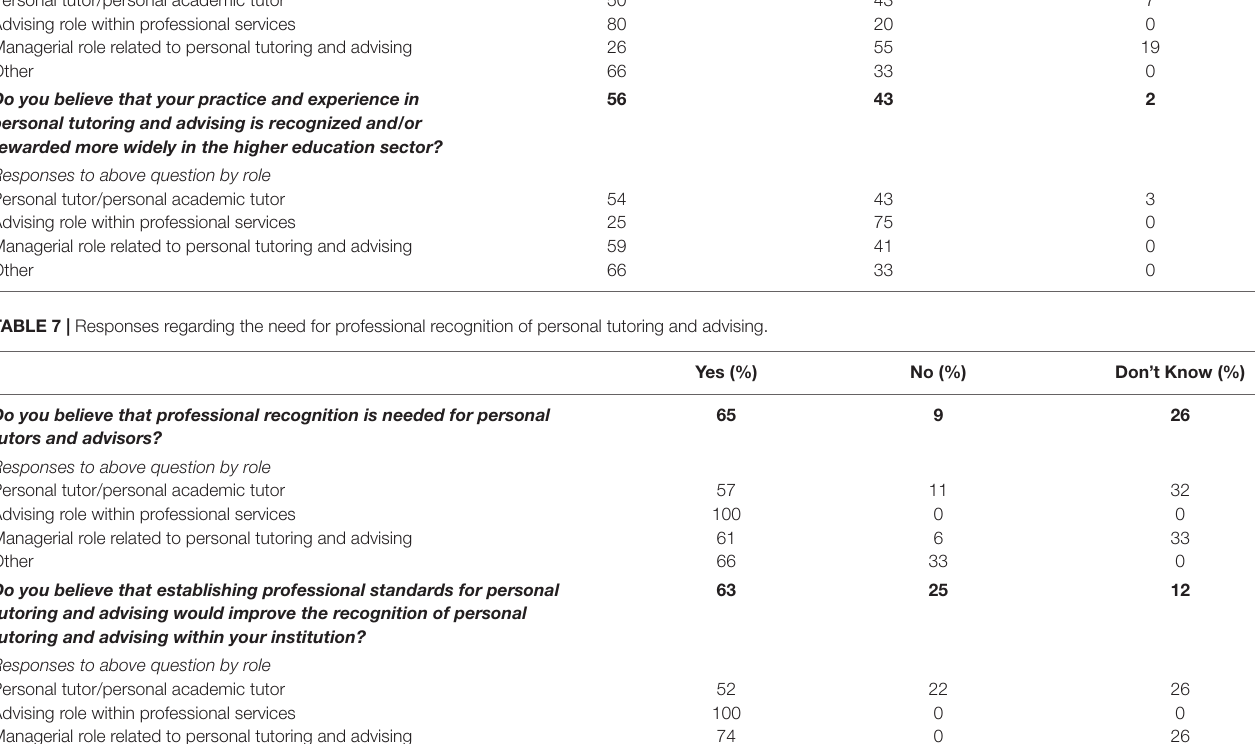
Not valued/Recognized/ Rewarded (%)